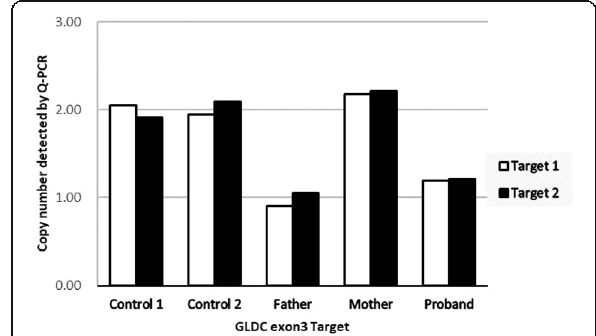
Fig. 3 Copy number variations analysis associates exon 3 of GLDC gene detected by Q-PCR. Two independent primers were used, the results of which are labeled as Target 1 and Target 2 respectively. The proband and his father both having a CN=1 indicated a heterozygous deletion of exon 3, and his mother had a CN=2, identical to the control samples, indicating a normal copy numbers of exon